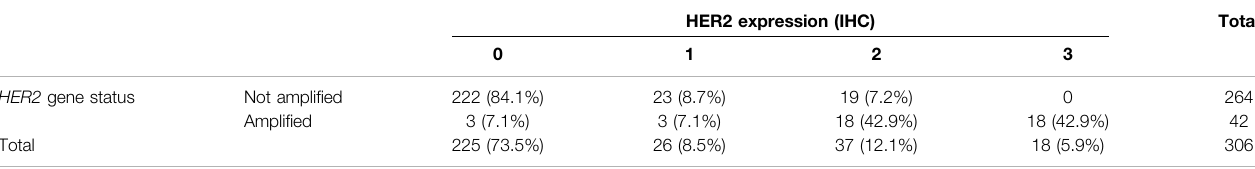
TABLE 1 | HER2 overexpression and ampli fi cation of 306 gallbladder carcinomas